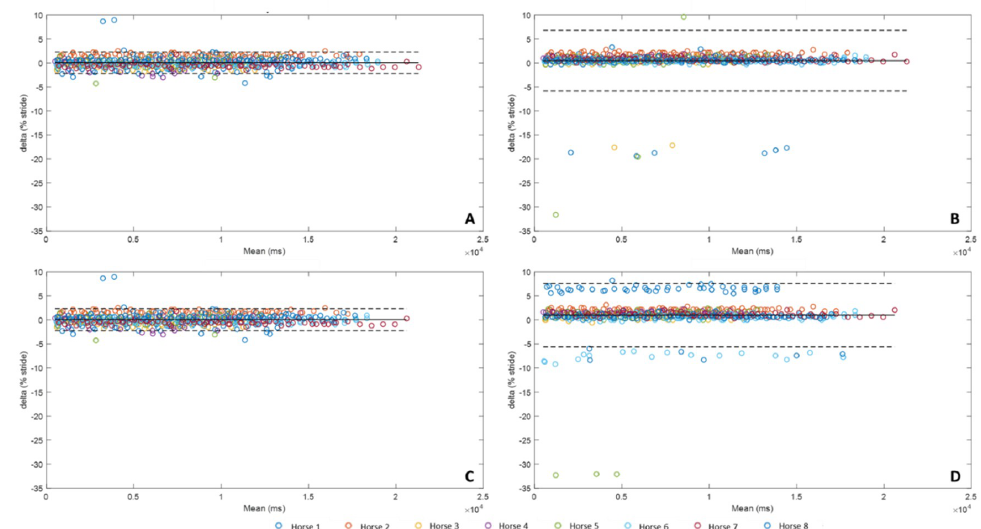
Figure 6. Bland‐Altman comparison of the Foot off detection of the four methods developed with IMU data and MoCap Foot off detection. Accuracy (bias between each method and MoCap) and limits of agreement (95% limits of agreement) of method A were represented on the upper left corner ( A ), method B on the upper right corner ( B ), method C on the lower left corner ( C ), and method D on the lower right corner ( D ).